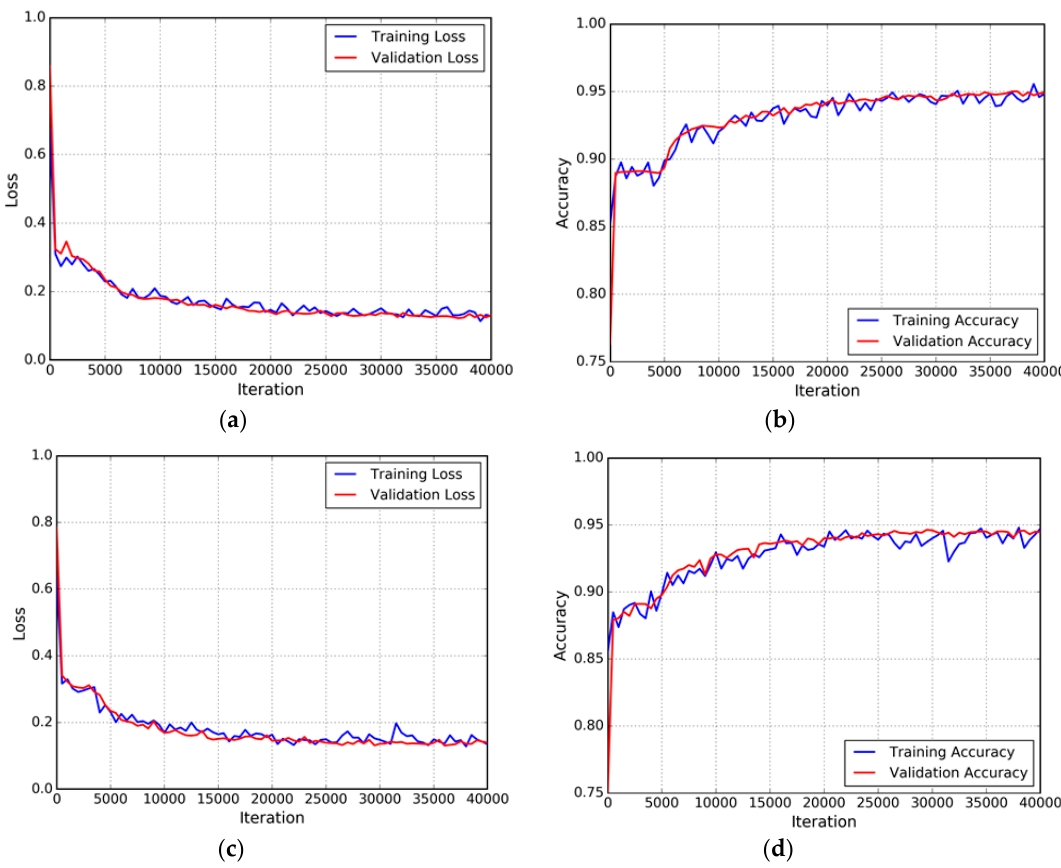
Figure 4. Iteration plot on the Massachusetts satellite data sets of variations of the proposed methods: fully convolutional network (FCN) and ELU-FCN. The x-axis corresponds to the number of iterations, and the y-axis refers to the measure. Each row refers to a different model. ( a ) plot of model loss (cross-entropy) on the training and validation datasets for FCN; ( b ) plot of accuracy on the training and validation datasets for FCN; ( c )plot of model loss on the training and validation datasets for ELU-FCN; and ( d ) plot of accuracy on the training and validation datasets for